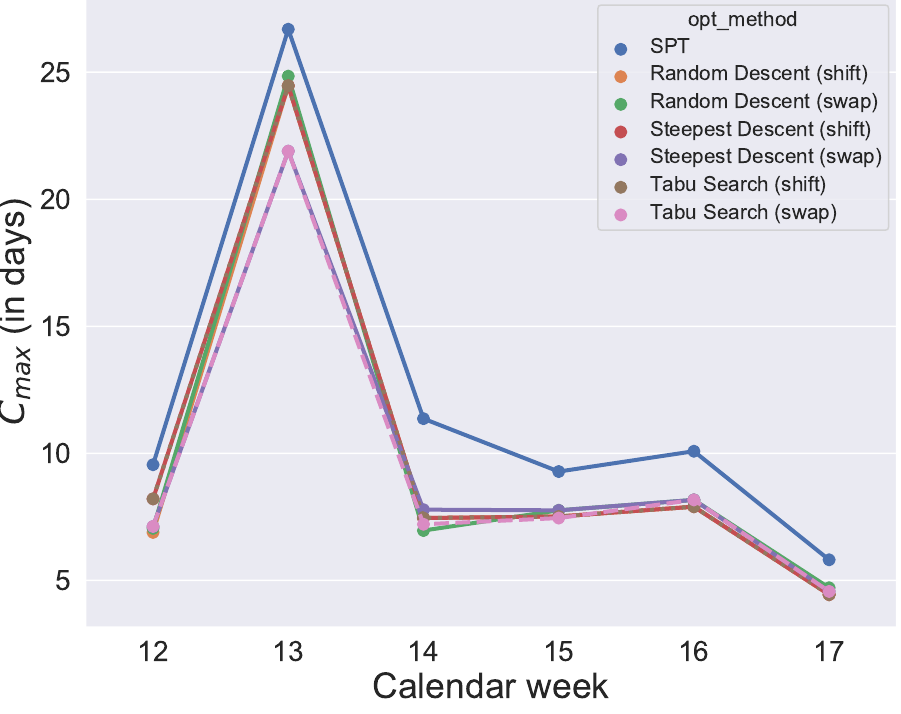
Figure 10. Optimization results for quantile 92%.